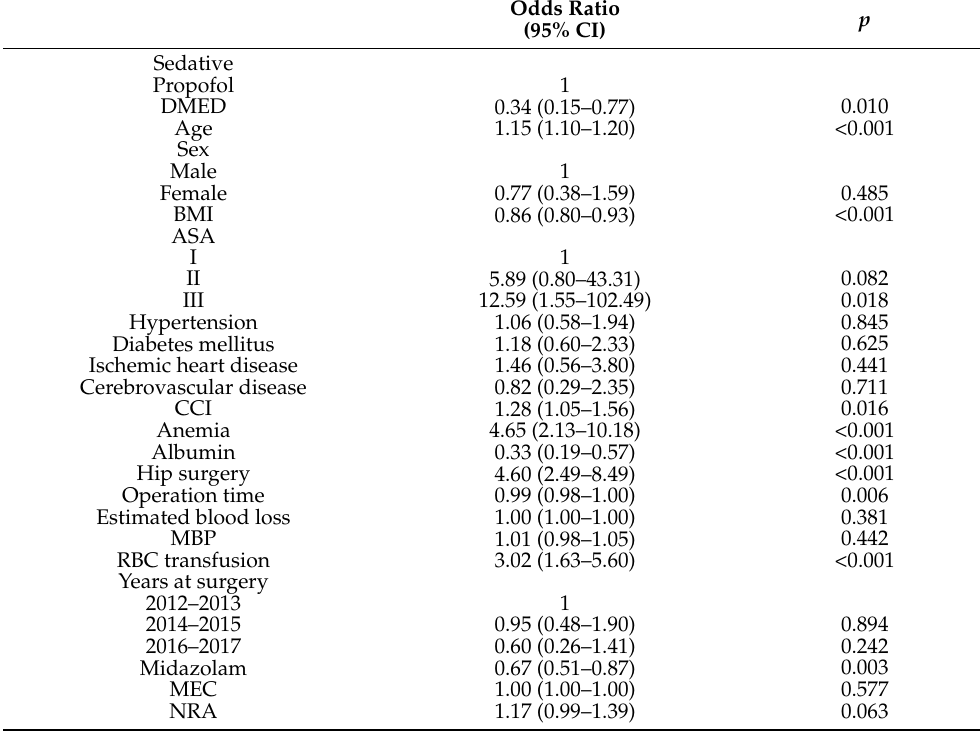
Table 3. Results of univariate analysis of variables associated with POD in the 1045 cohort of patients.